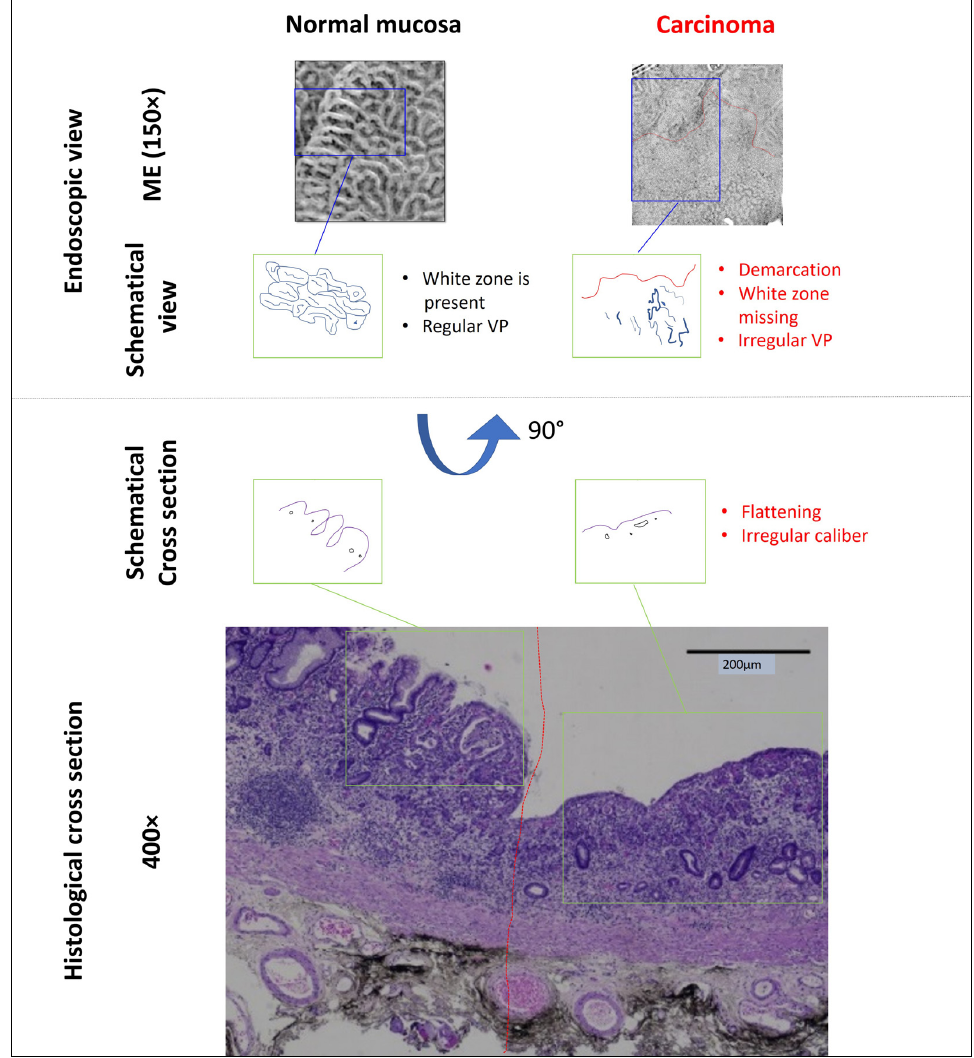
Figure 4. Comparison of magnification endoscopy view (ME) and histological cross section of normal mucosa and an early well differentiated adenocarcinoma in the antrum (compare Figure 2). The components of the ME picture, vascular pattern (VP) and surface pattern (SP), represent marginal crypt epithelium (i.e., the “white zone”) and subepithelial capillaries, respectively. SP and white zone are missing in the malignant area, VP is irregular. This corresponds to a flattening of the epithelium and irregular caliber of the capillary vessels in the histological specimen (obtained after endoscopic submucosal dissection of the lesion, which is characterized in Figure 2).